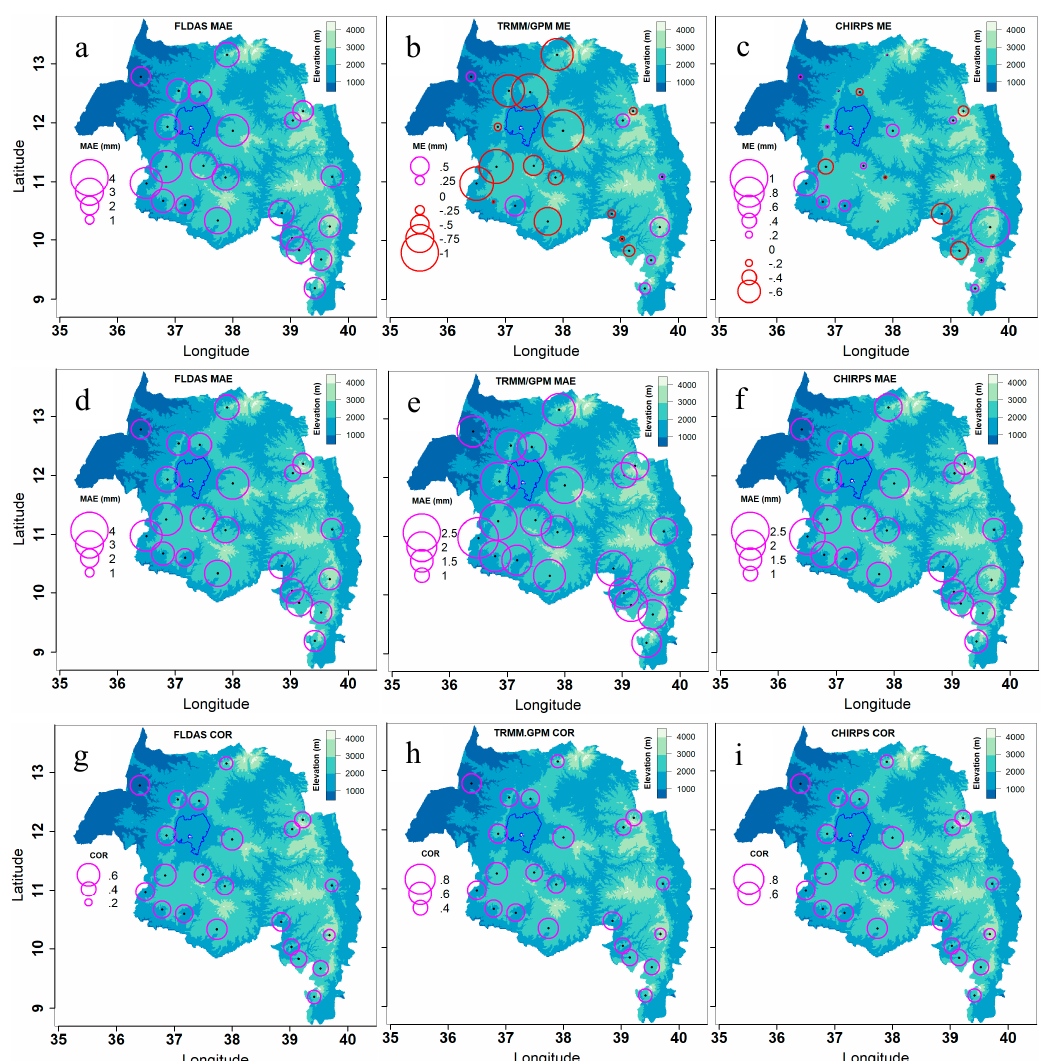
Figure 12. Pixel-level satellite/interpolated daily rainfall data accuracy statistics spatial distribution for 22 meteorological stations in Amhara Region, Ethiopia for 2003–2016. Note the legend scale differences.